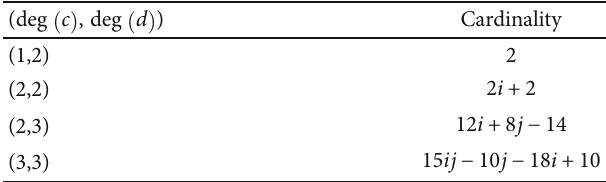
- II ½ i , j (cid:2) . 4